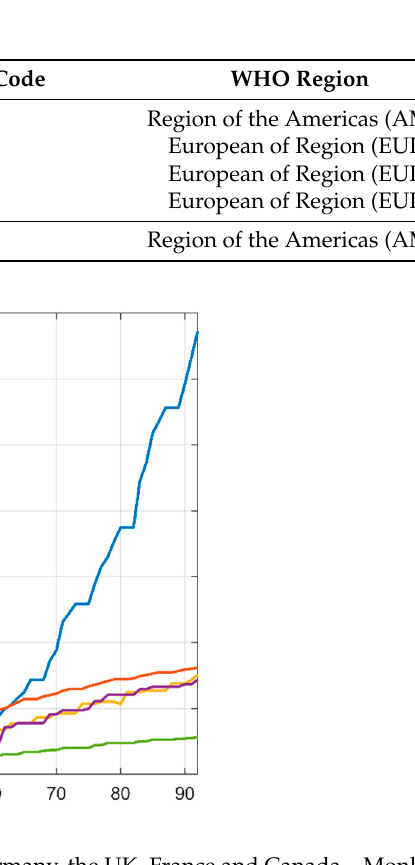
Figure 6. Daily confirmed cases for the USA, Germany, the UK, France and Canada—Monkeypox.